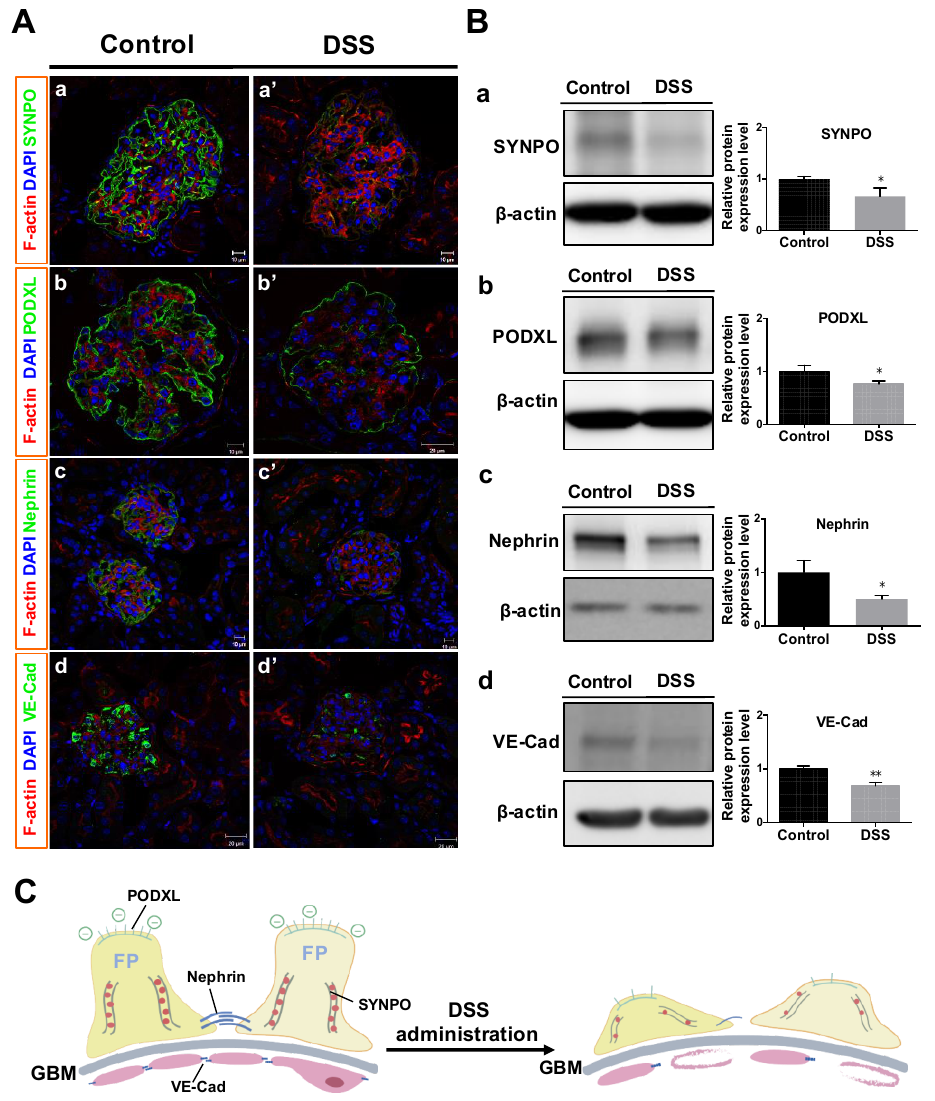
Figure 5. Changes in GFB-related proteins in mice after DSS administration. Immunofluorescent microscopy ( A ) and Western blot analysis of protein expression ( B ) against synaptopodin (A-a, A-a’; B-a; 100 kDa), podocalyxin (A-b, A-b’; B-b; 130 kDa), nephrin (A-c, A-c’; B-c; 185 kDa) and VE-cadherin (A-d, A-d’; B-d; 130 kDa) in glomeruli were conducted for control and DSS-colitis mice. ( B ) Representative bands (left), and relative band intensity ratios (right) were analyzed. ( C ) Illustration of GFB-related proteins changes in this study. All values are means ± SEM ( n = 6), * p < 0.05 and ** p < 0.01 vs. control. Scale bars = 10 µ m (A-a, A-a’, A-b, A-c, A-c’); 20 µ m (A-b’, A-d, A-d’). Abbreviation: SYNPO, synaptopodin; PODXL, podocalyxin; VE-Cad, VE-cadherin; FP, foot